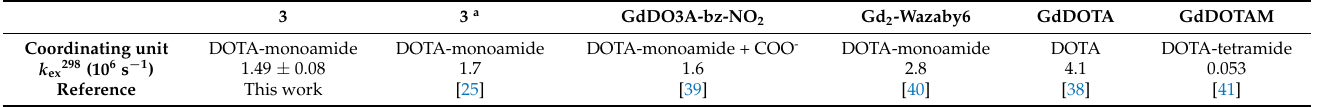
a Obtained from fitting of NMRD data from ref.